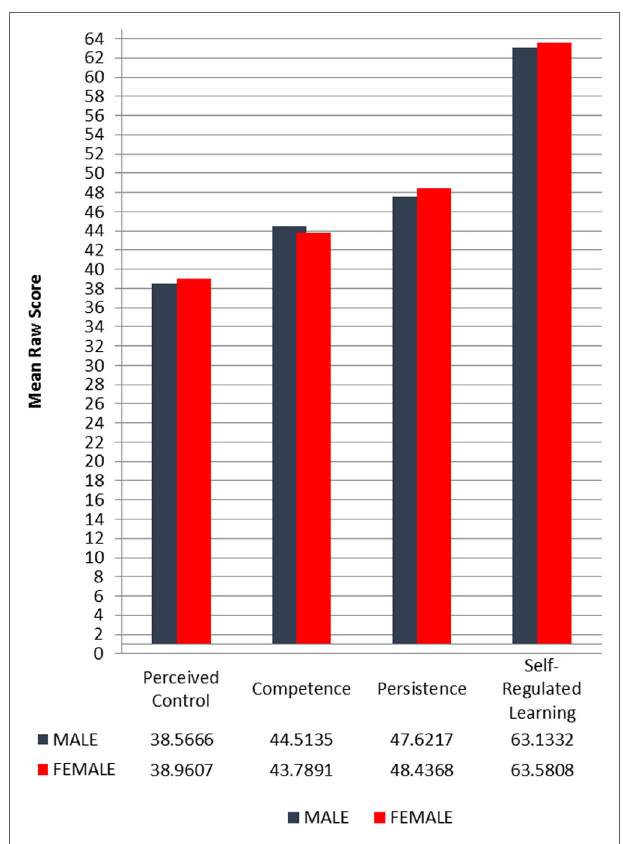
FigUre 2 | Male and Female Junior High Students’ Raw Score on Academic Self-efficacy Scale